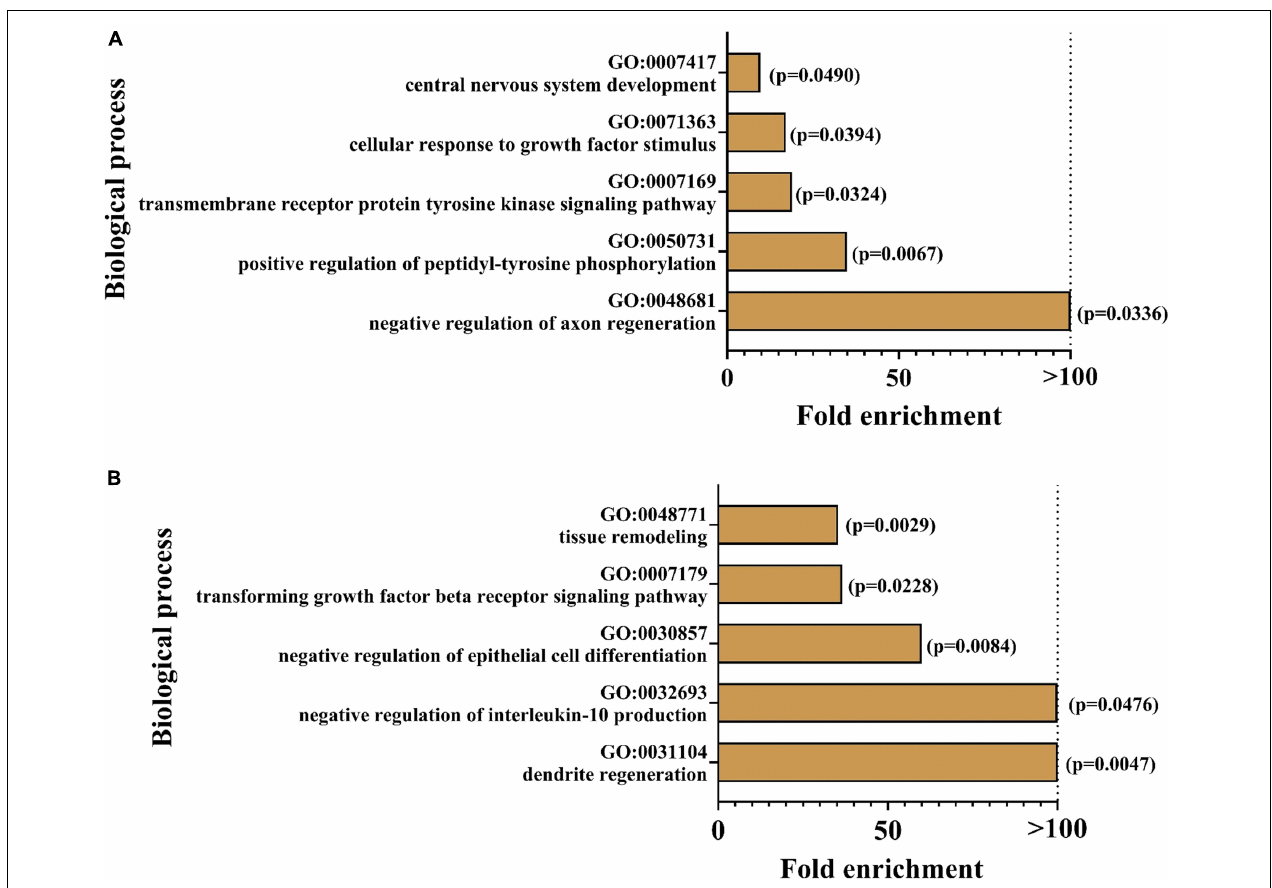
FIGURE 6 | Enrichment analysis was performed using geneontology.org (GO); top five of the most strongly enriched biological processes are depicted for (A) App NL − G − F knock-in versus C57BL/6J wild type mice and (B) hyperhomocyste-inemic versus control App NL − G − F knock-in mice; p -values are expressed in brackets for each enriched biological